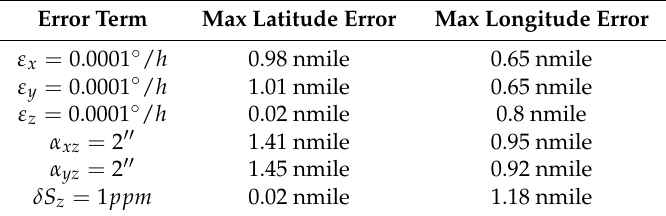
Table 2. Max position error in numerical simulation of the mathematical model. Figure 3. Single error test result in a numerical simulation of the mathematical model.